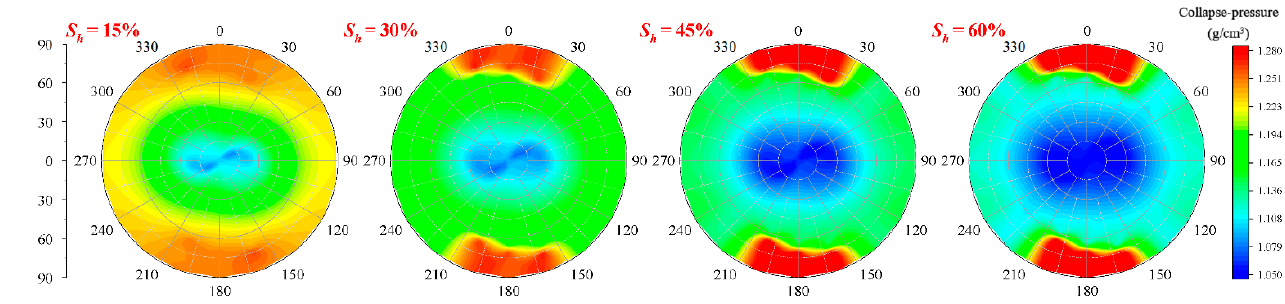
Figure 5. Cloud diagram of the collapse pressure gradient distribution under M-C failure criterion.